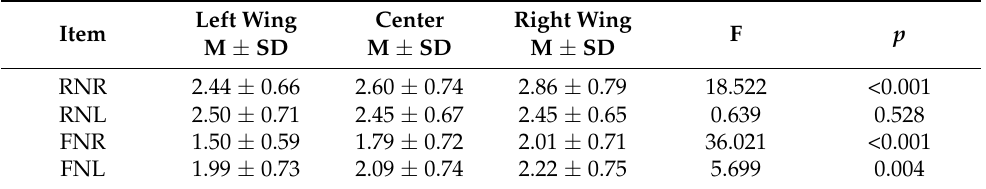
Table 2. Means (M), standard deviations (SD) and univariate effects of belief in real news (pro-left RNL and pro-right RNF) and fake news (pro-left FNL and pro-right FNR) by political ideology. Item